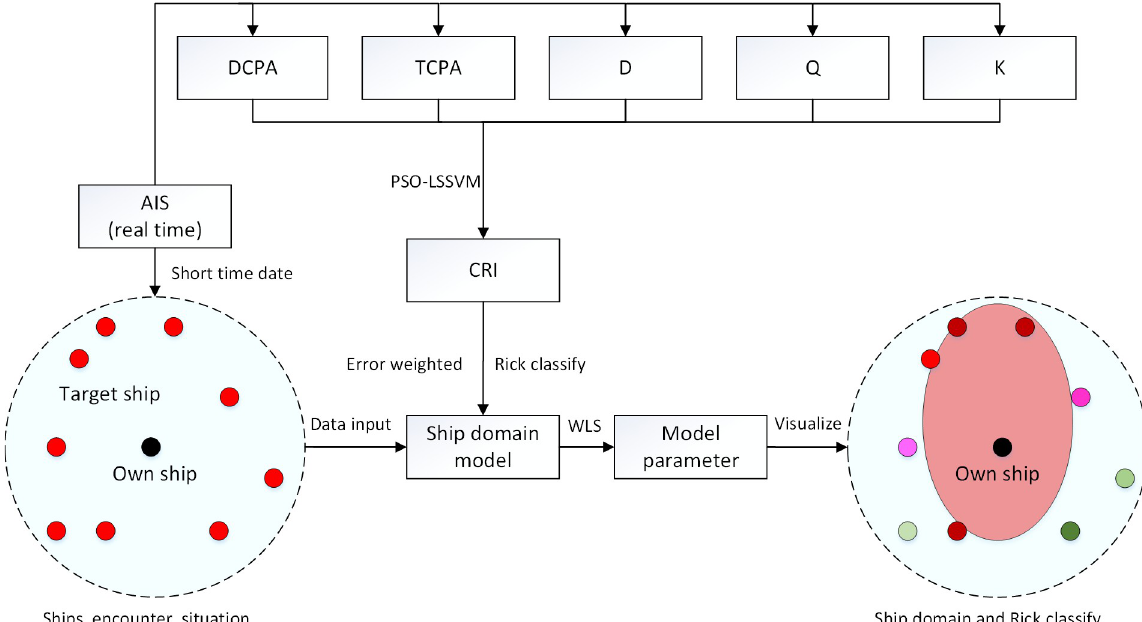
Fig 1. Schematic diagram of online identification of the ship